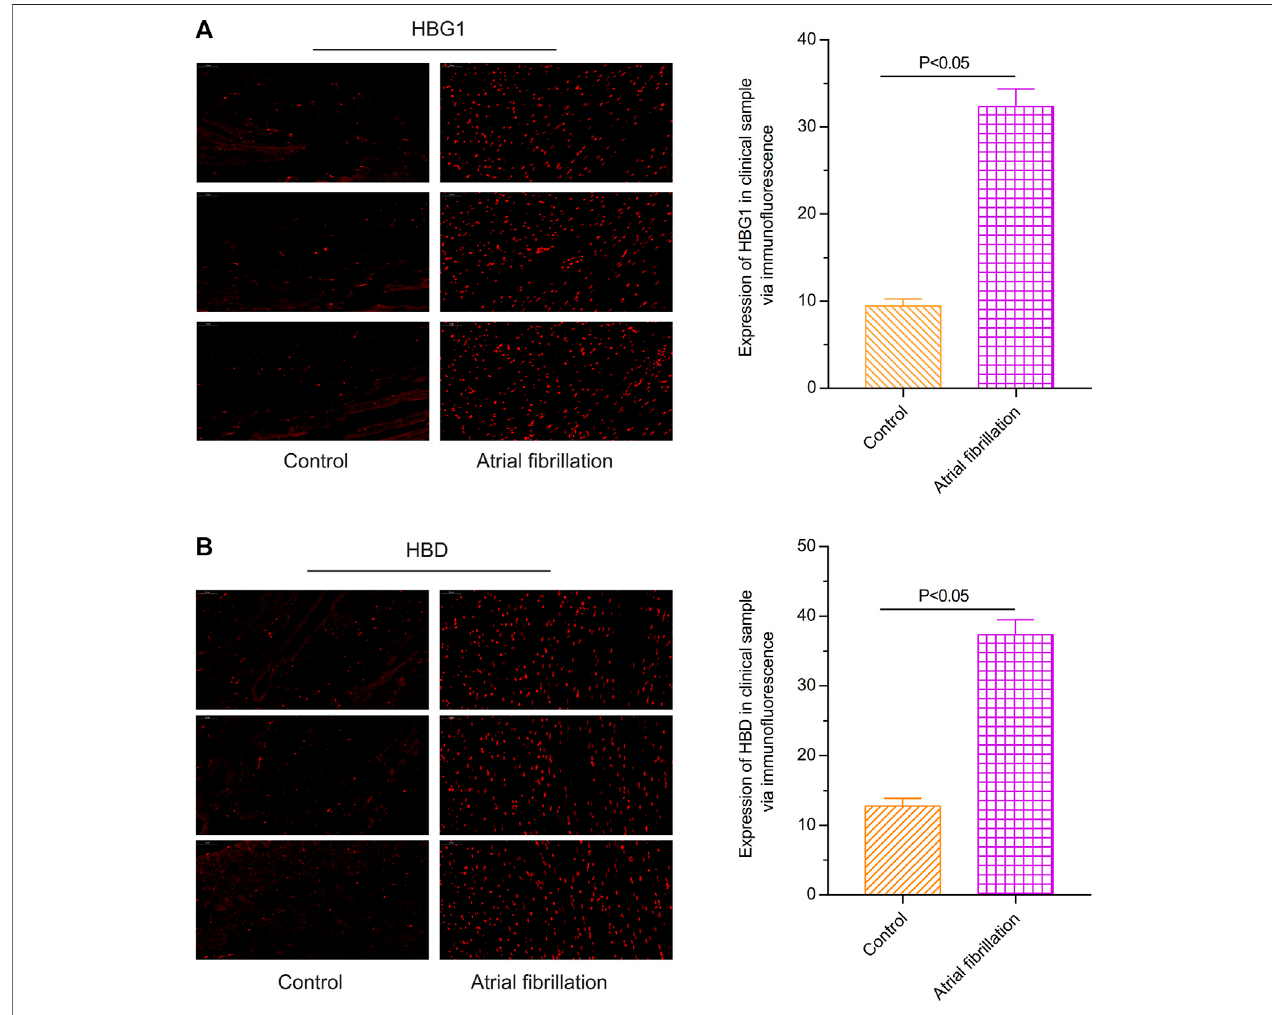
FIGURE 1 | Expressions of HBG1 and HBD in the red blood cells of the patients with atrial fi brillation via the immuno fl uorescence assay. Compared with the red blood cells of the control individuals, the expressions of (A) HBG1 and (B) HBD were higher in the red blood cells of the patients with atrial fi brillation.